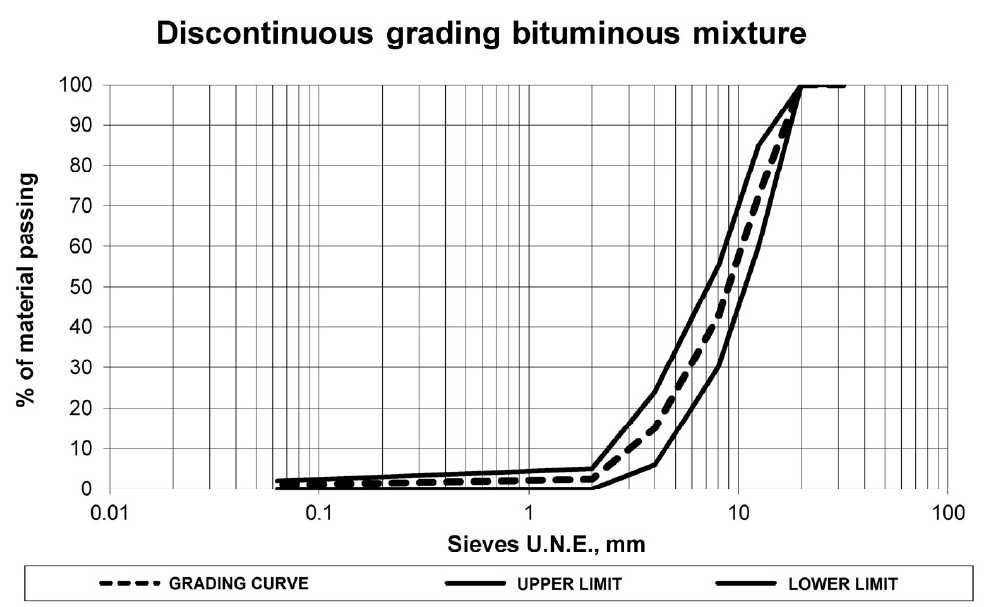
Figure 3. Grading curve of the bituminous mixture conformed with leaching residue and bitumen emulsion.